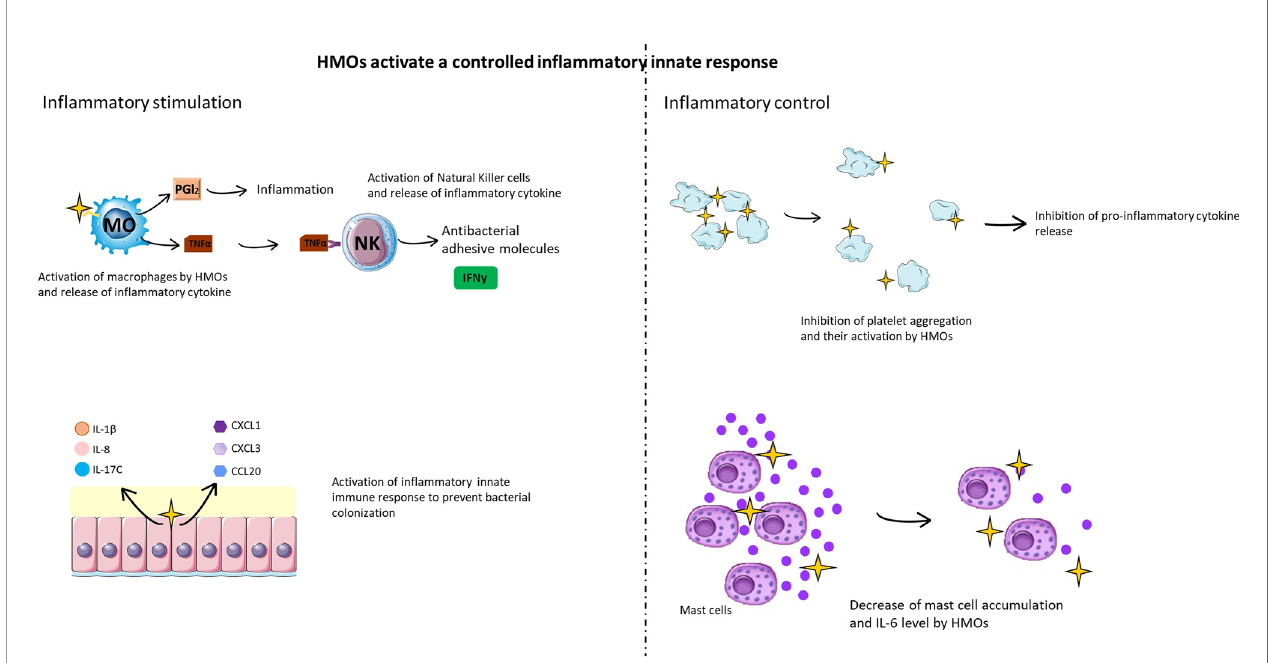
FIGURE 6 | HMOs activate a controlled in fl ammatory innate immune response. HMOs participate in the in fl ammatory immune response, stimulating cellular (macrophages, mast cells, natural killer cells, and platelets) and molecular (cytokines and chemokines) actors of the innate response to fi ght against infection (left fi gure). In parallel, HMOs limit this in fl ammatory reaction in a cellular and molecular feedback loop (right fi